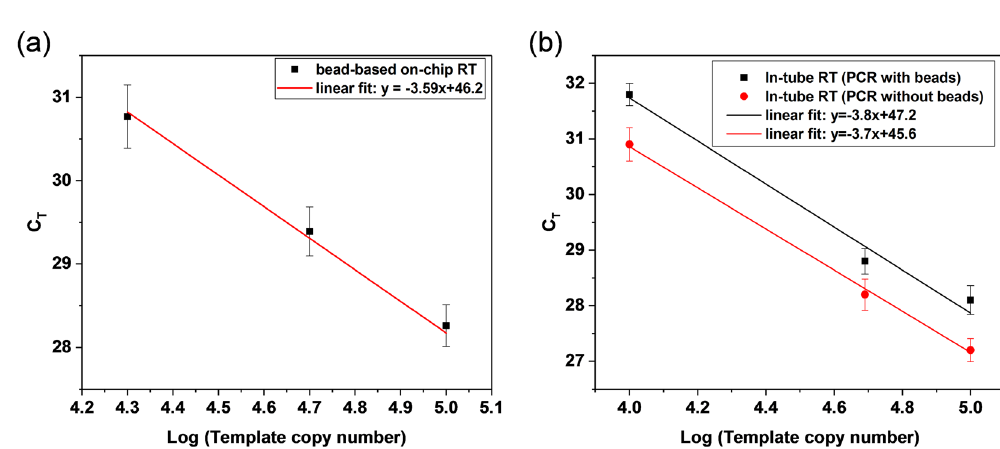
Figure 2. ( a ) Mean and standard deviation of on-chip bead-based RT followed by offchip bead-based qPCR. ( b ) Mean and standard deviation of in-tube RT followed by bead-based offchip qPCR and solution-based offchip qPCR,